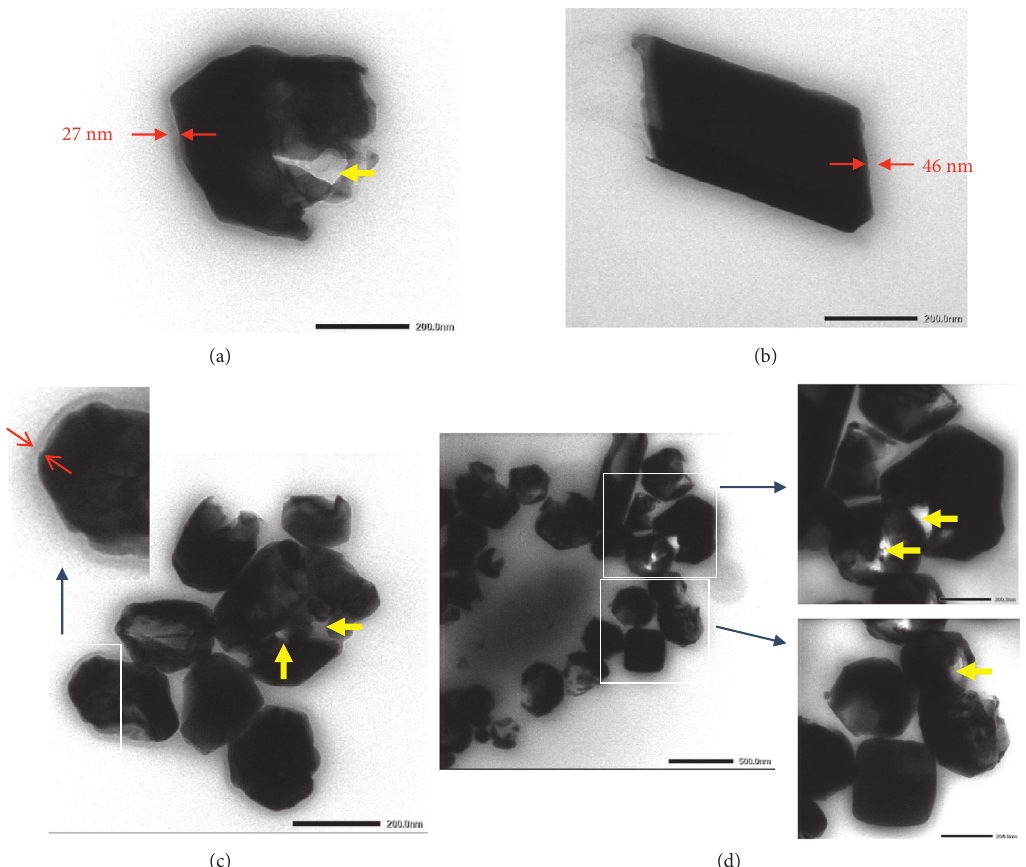
Figure 3: TEM images of CuNPs in solution after 90min of reaction. Blue arrows point to magnified areas in the white rectangles. Red arrows show the capping layers surrounding CuNPs. Yellow arrows show “holes” inside CuNP aggregates.